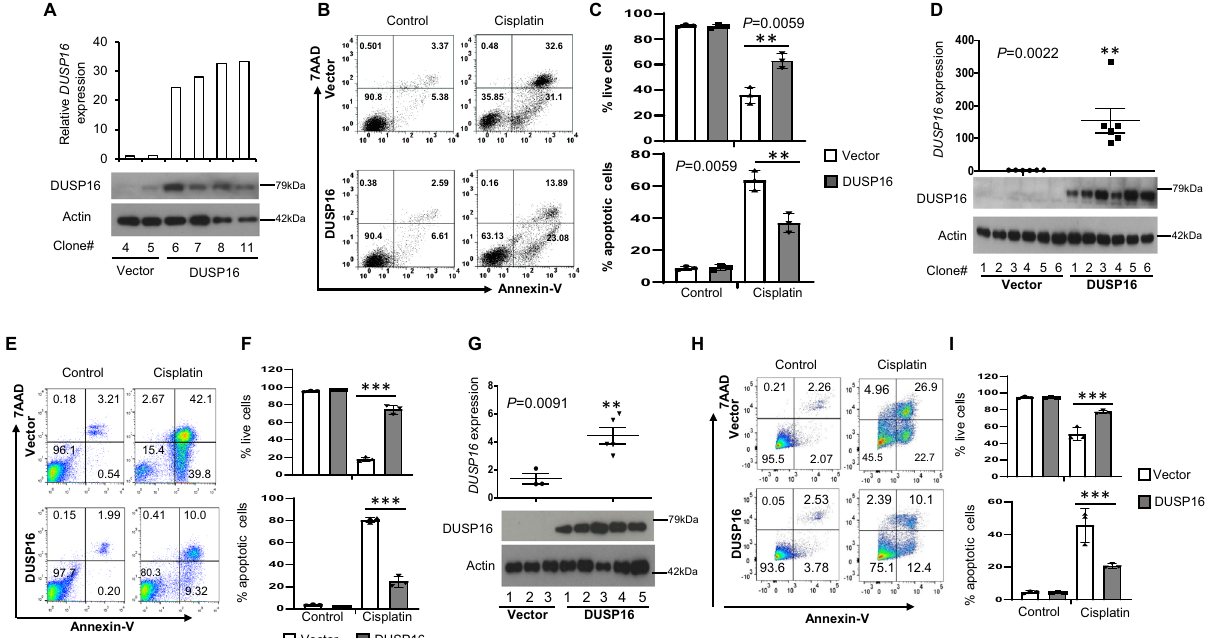
Fig. 2 Overexpression of DUSP16 in various types of cancer cells results in increased resistance to cisplatin. A mRNA and protein levels of DUSP16 in HK-1 cells transfected with vector or human DUSP16 cDNA were quanti fi ed by qPCR and western blot analysis, respectively. Bar chart shows mRNA expression of vector ( n = 2) and DUSP16 ( n = 4) expressing clones. B , C Comparison of apoptosis induction between vector- and DUSP16 -transfected cells after cisplatin treatment was carried out by staining the cells with AnnexinV and 7AAD followed by fl ow cytometry analysis ( B ). Bar charts show the percentage of apoptotic (both AnnexinV + 7AAD + and AnnexinV + 7AAD − cells) and surviving cells, respectively, in both untreated and cisplatin-treated groups with mean ± SEM, n = 3 biologically independent samples ( C ). Statistical analysis was performed using two-tailed unpaired t -test. The data are representative of 3 experiments with similar results. D DUSP16 mRNA expression in DLD-1 cells transfected with vector ( n = 6) or human DUSP16 cDNA ( n = 6) quanti fi ed by qPCR. Statistical analysis was performed using two-tailed unpaired t -test. DUSP16 protein expression in these clones was assessed by Western blot. E , F Apoptosis induction between the vector- and DUSP16 -transfected DLD-1 cells after cisplatin treatment was analyzed ( E ) and bar charts show the percentage of apoptotic and surviving cells in both untreated and cisplatin-treated groups with mean ± SEM, n = 3 biologically independent samples ( F ). Statistical analysis was performed using two-tailed unpaired t -test. *** P < 0.0001. G DUSP16 mRNA and protein expression in Nugc3 cells transfected with vector or human DUSP16 cDNA was determined by qPCR and immunoblotting, respectively. Dot plot shows DUSP16 mRNA expression in vector ( n = 3) and DUSP16 ( n = 5) expressing clones. Statistical analysis was performed using two-tailed unpaired t -test. H , I Apoptosis induction between vector- and DUSP16 -transfected Nugc3 cells after cisplatin treatment was analyzed and bar charts ( I ) show the percentage of apoptotic and surviving cells in untreated and cisplatin-treated cells, respectively, with mean ± SEM, n = 3 biologically independent samples. Statistical analysis was performed using two-tailed unpaired t -test. *** P < 0.0001. The data are representative of 3 experiments with similar results. Source data are provided as a Source data fi